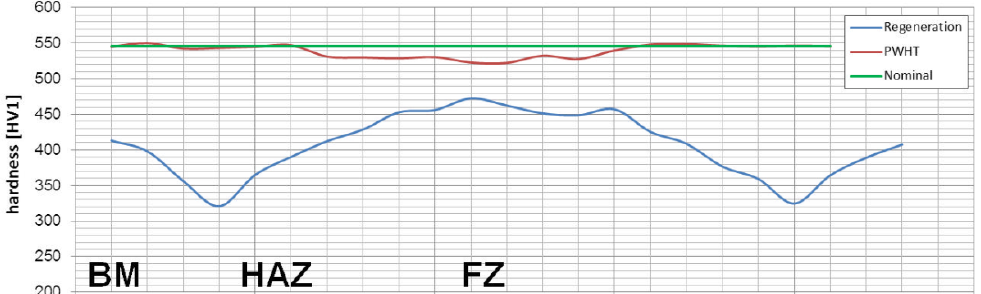
Figure 22. The hardness distributions for performed welding processes of 55Si7 steel. The nominal value corresponds to the base material after isothermal heat treatment before the welding process.